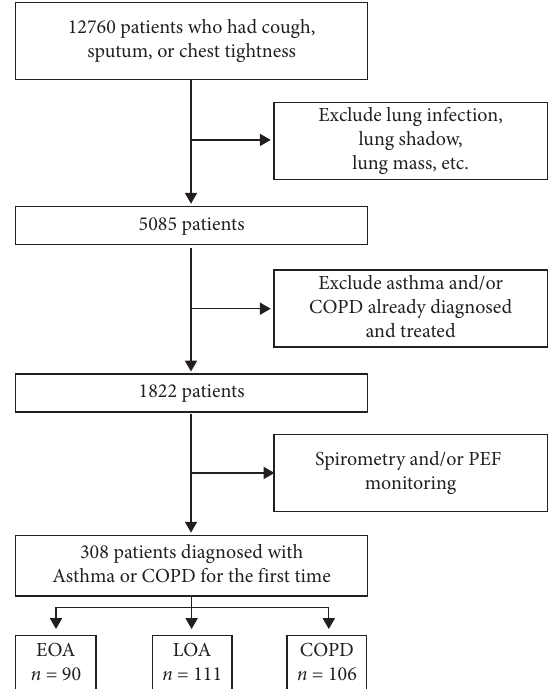
Figure 1: Study profile-The number of patients enrolled and analyzed in the